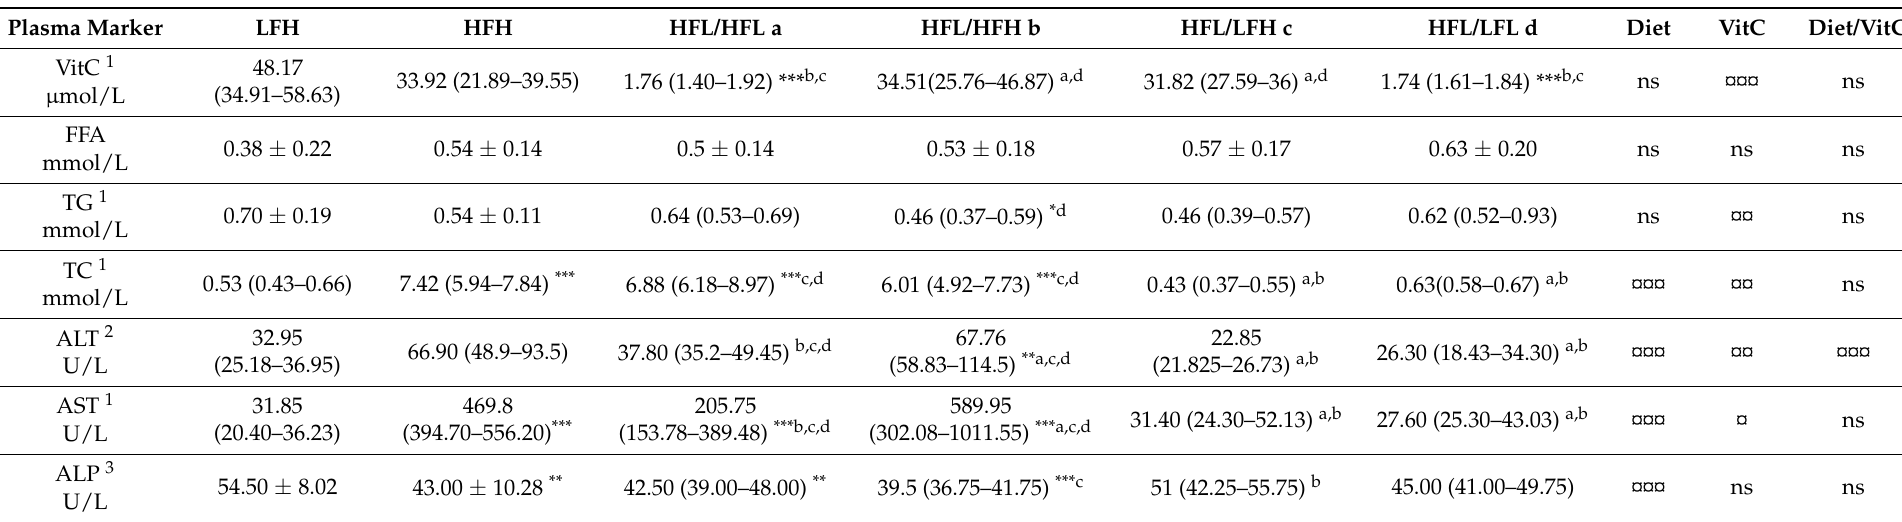
Table 2. Plasma levels for all groups following 32 weeks on